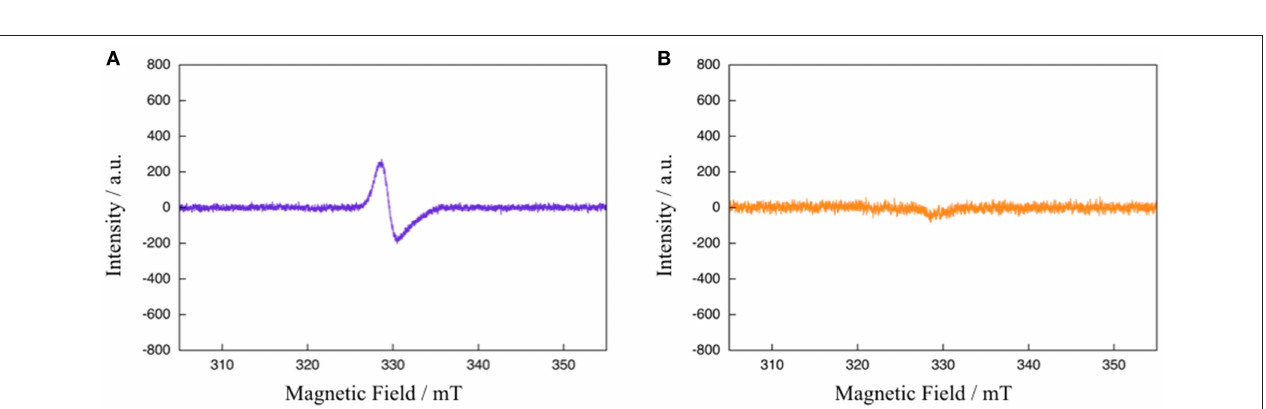
FIGURE 5 | ESR spectra of 1 in CH 3 CN:TEOA = 4:1 v/v solution after photoirradiation ( λ > 420nm) for 20s (A) and 900s (B) at 173K.